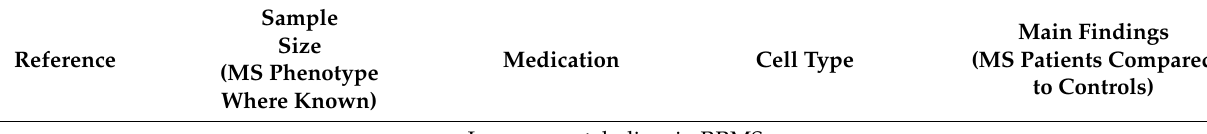
Table 1. Research providing evidence for altered immunometabolism in MS